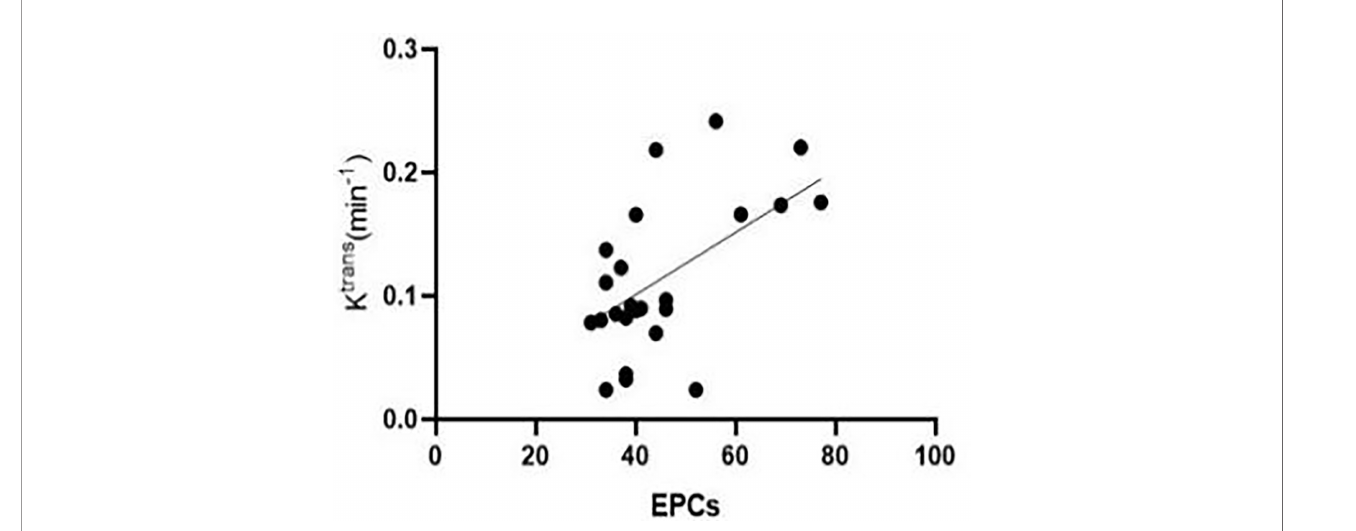
FIGURE 5 | At the third week after successful modelling, EPCs in the peripheral blood of experimental rabbits correlated positively with K trans